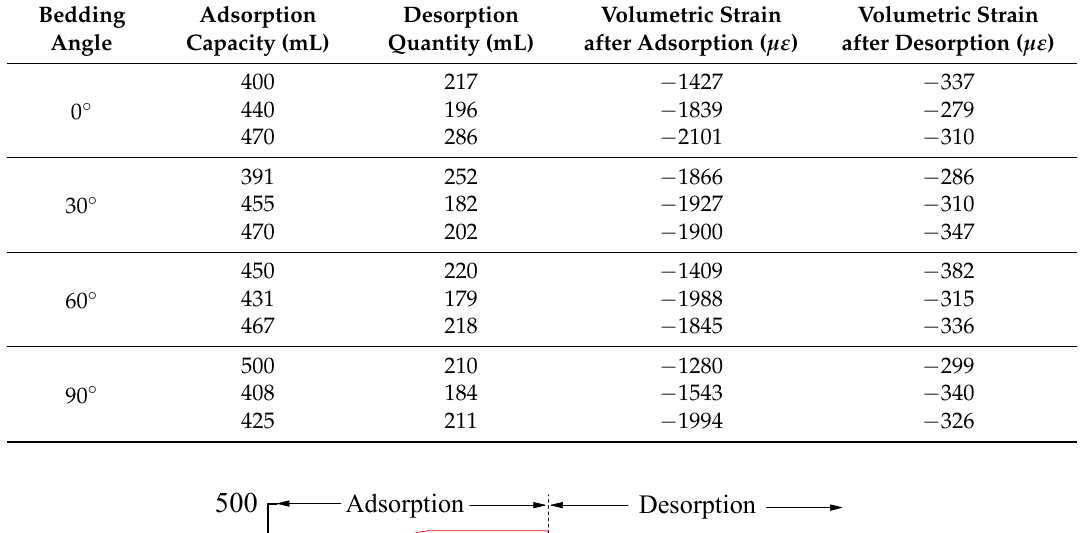
Table 2. Final adsorption capacity, desorption capacity, and deformation of the samples in the adsorption–desorption experiment.